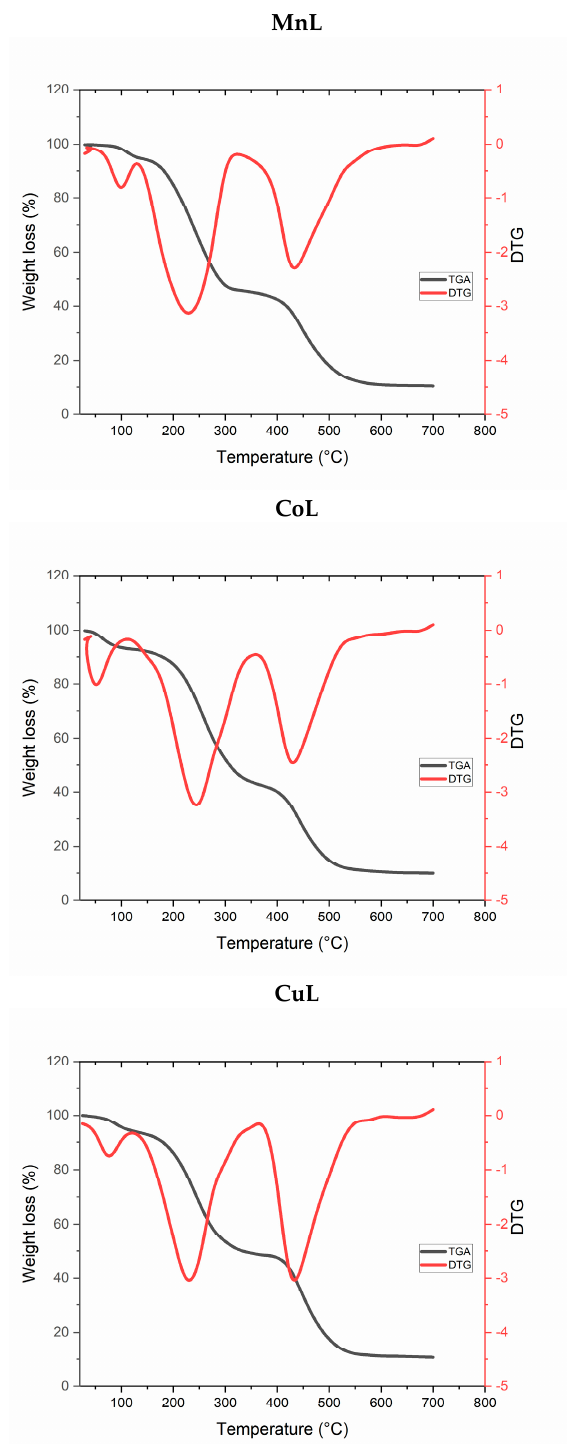
Figure 1. Thermal decomposition of the synthesized complexes.